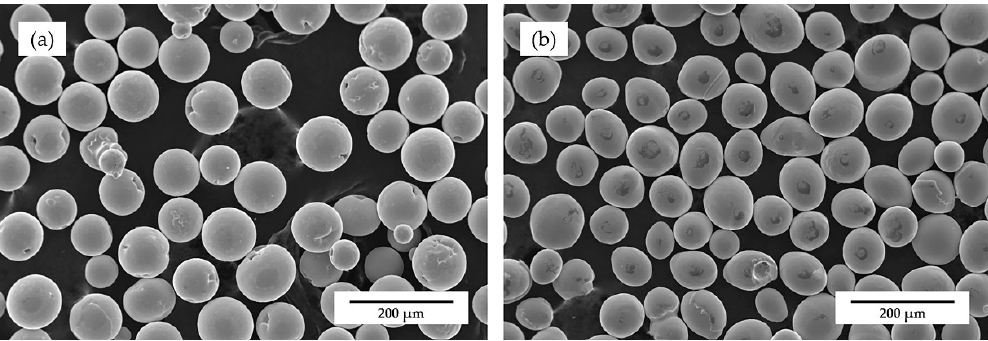
Figure 1. Morphologies of the powders: ( a ) single Ni powder; ( b ) 55NiTi alloy powder. Table 1. Chemical composition of Ni and 55NiTi alloy powders (wt.%). Powders